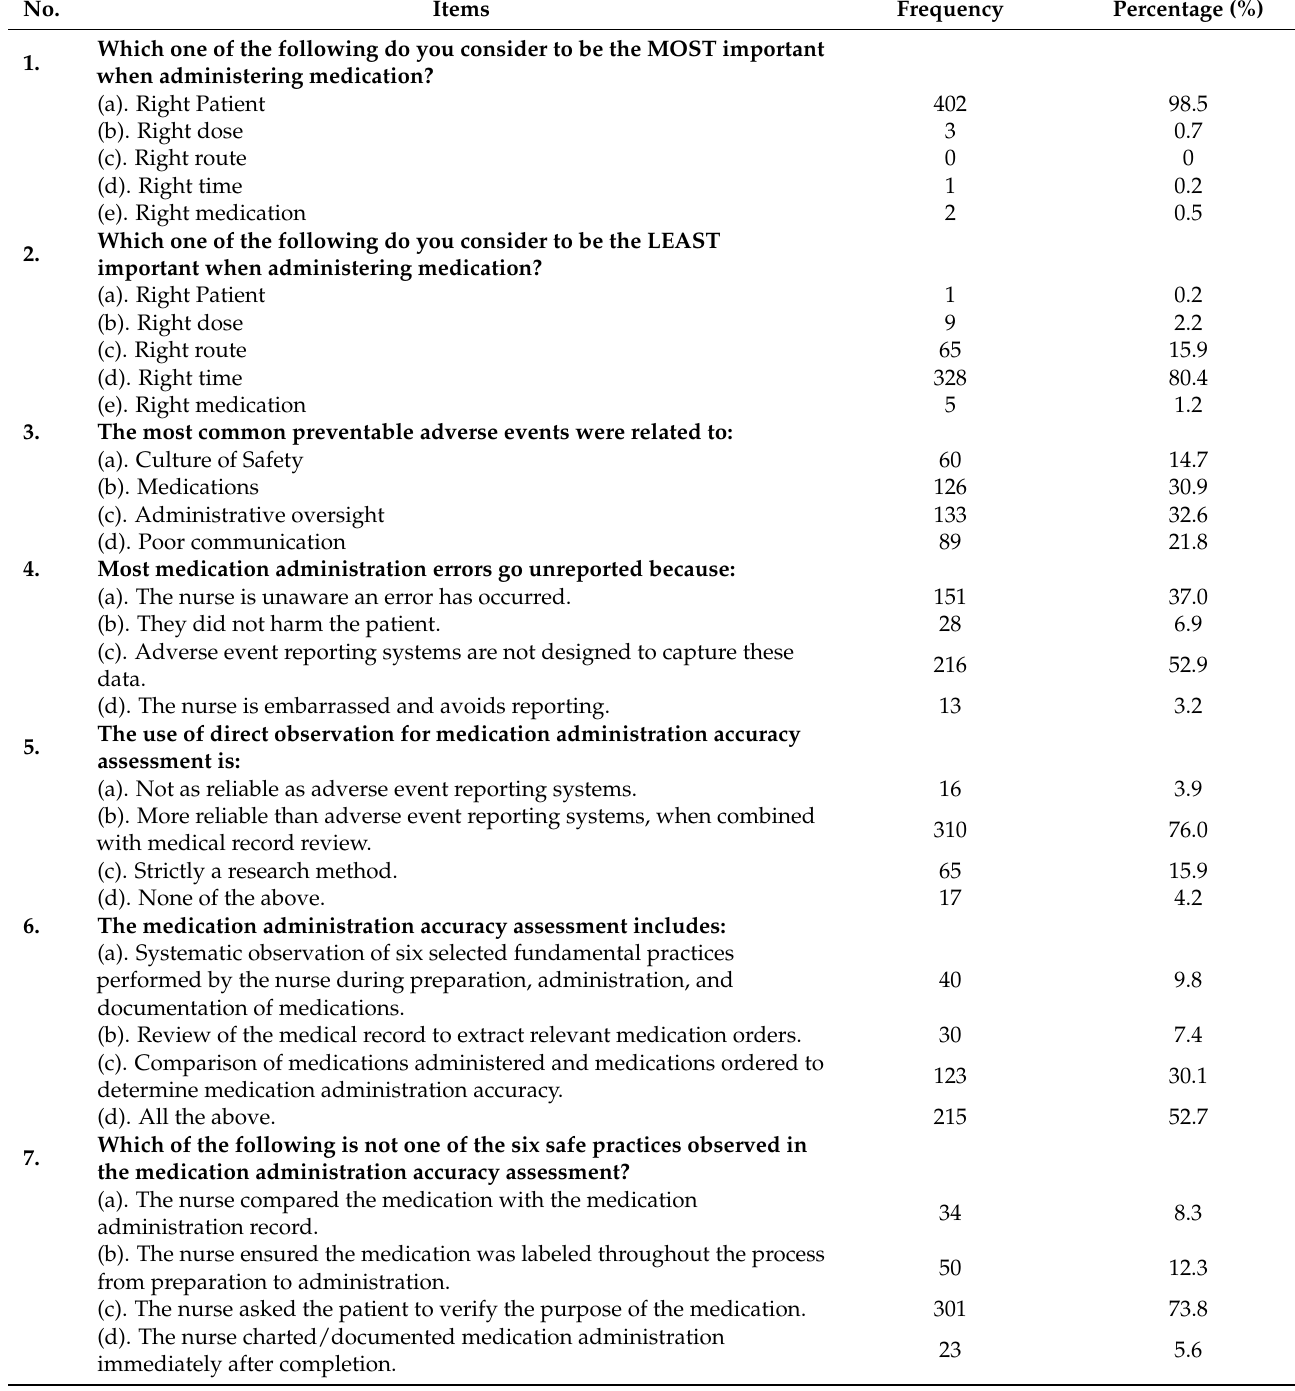
Table 2. Distribution of nurses’ knowledge regarding medication